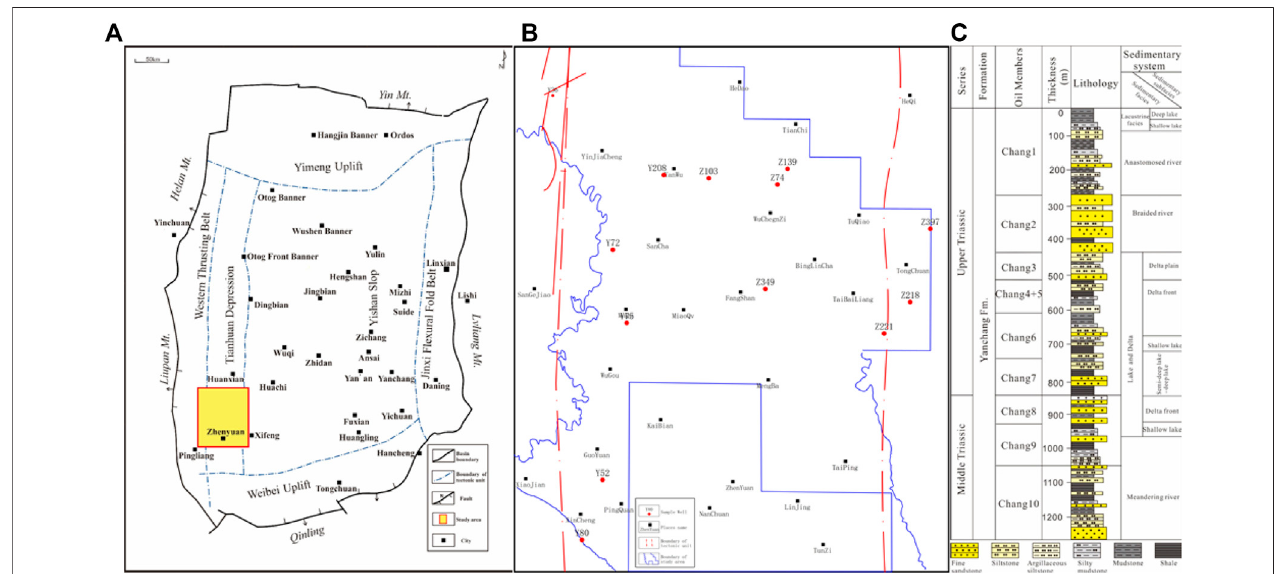
FIGURE 1 | (A) Structural units and geological setting of the Ordos Basin (modi fi ed from References Zou et al., 2012 and Li et al., 2016). (B) Location of the study area. (C) Triassic succession.